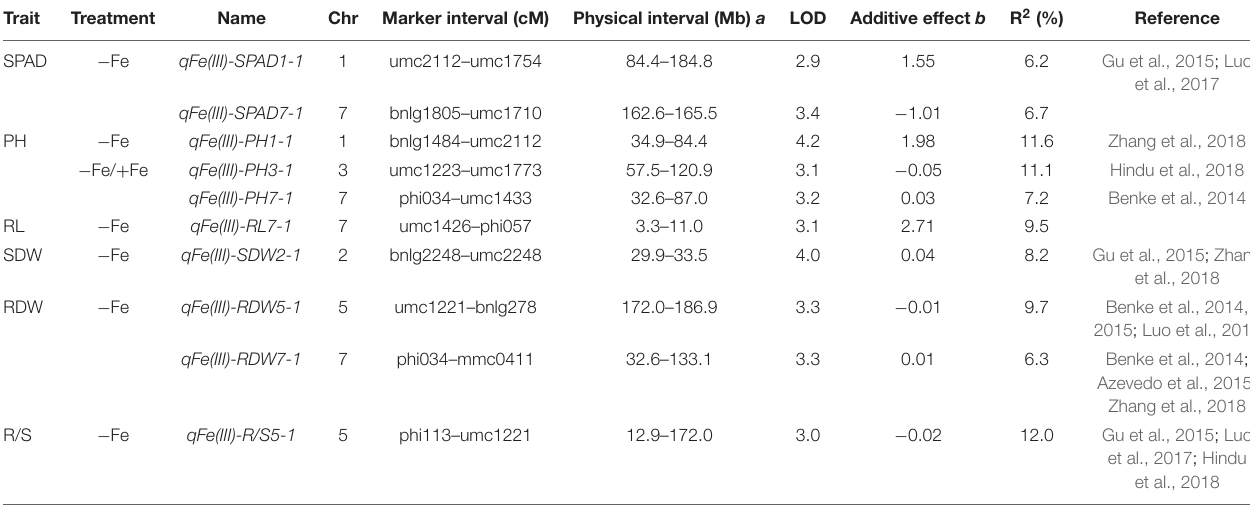
TABLE 3 | Quantitative trait loci (QTLs) associated with Fe deficiency tolerance. Trait